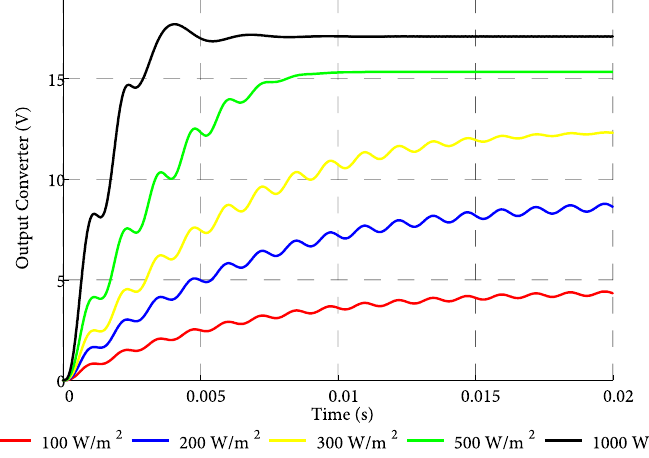
Figure 6. Output voltage of buck converter.